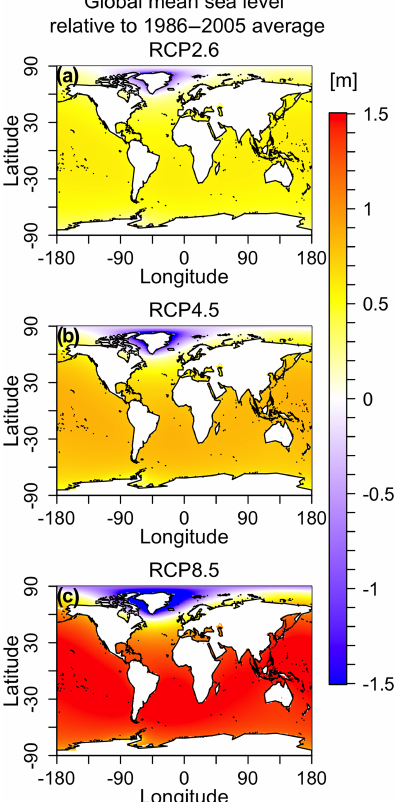
Figure 4. Regional projections of median sea-level changes under Representative Concentration Pathways (RCPs) (a) 2.6, (b) 4.5, and (c) 8.5 in the year 2100. Sea-level rise is presented relative to 1986– 2005 global mean sea level (meters).